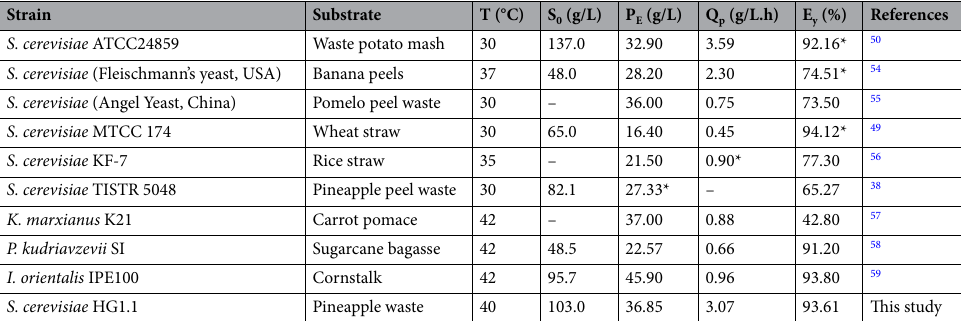
Pathway or function